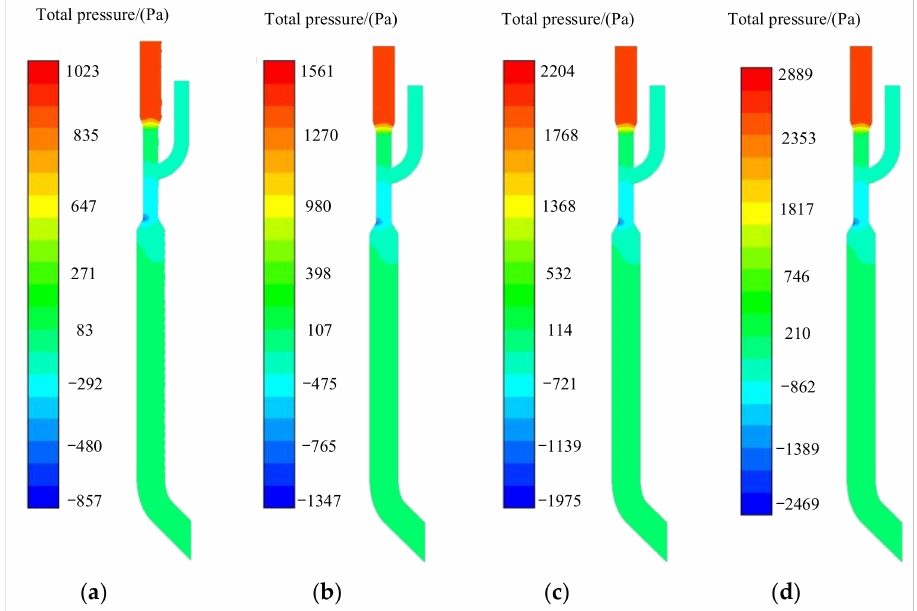
Figure 14. Airflow-pressure contours of different inlet-airflow velocities. ( a ) 20 m/s, ( b ) 25 m/s, ( c ) 30 m/s, ( d ) 35 m/s.